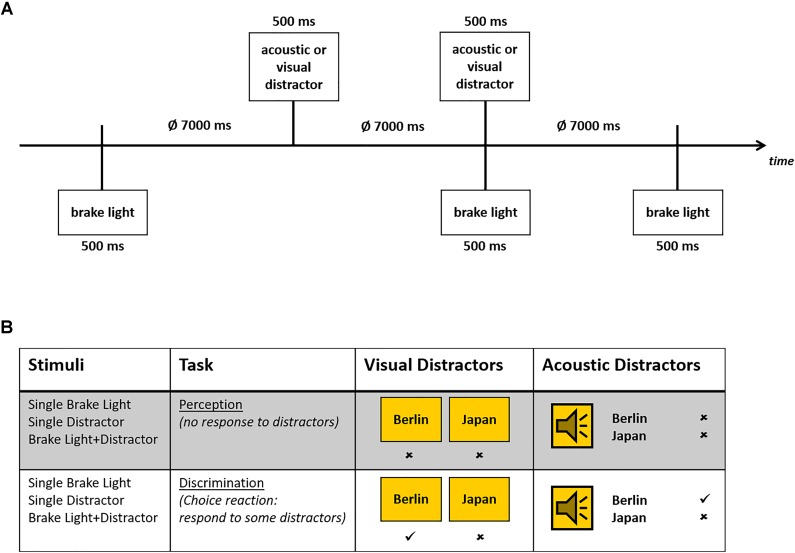
(A) Timing of the stimulus presentation in the driving task, in which brake lights and secondary stimuli were presented either alone or in combination. (B) Schematic overview of both task conditions with specific instructions, as well as visual and acoustic secondary stimuli. Correct responses (no response in perception condition or after secondary NoGo-stimuli, responses after Go-stimuli) are marked.